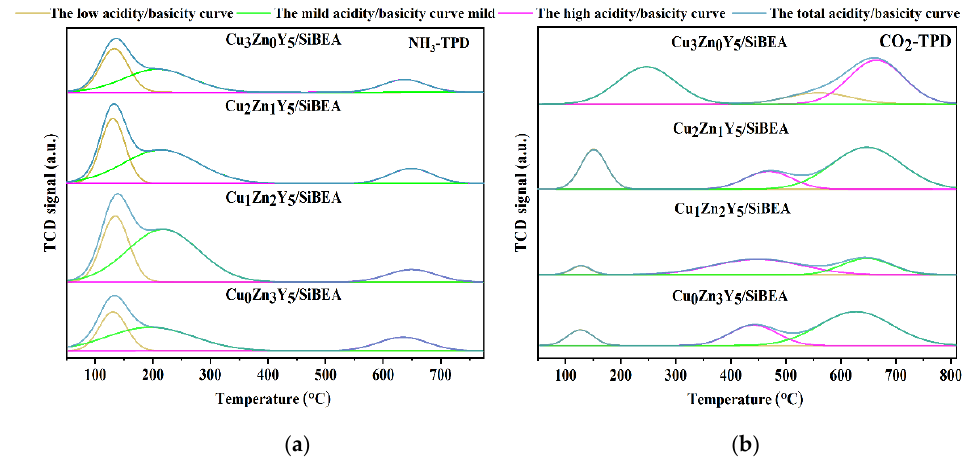
Figure 4. N 2 adsorption–desorption isotherms of SiBEA, CuZnY/SiBEA catalysts. Table 1. Specific surface area, pore volume, and pore size of SiBEA carrier and CuZnY/SiBEA catalysts.